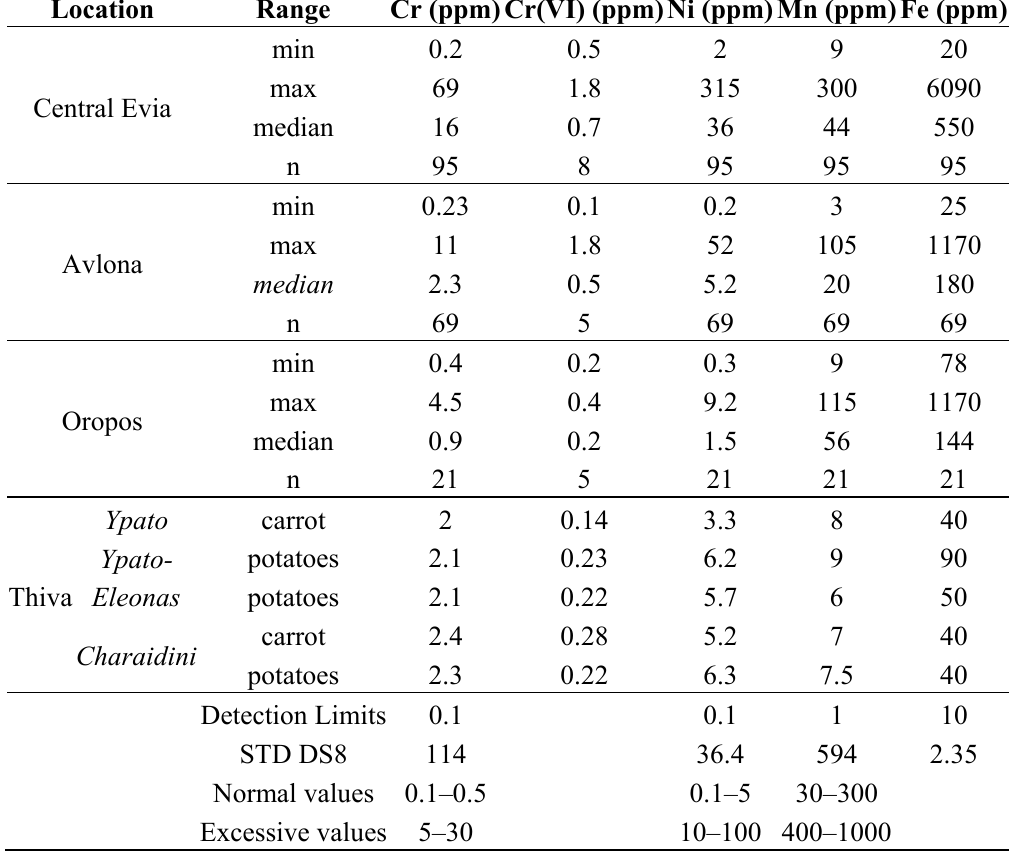
Table 3. Range and median of trace element contents in plants from the Assopos-Thiva basins and C. Evia. Data from